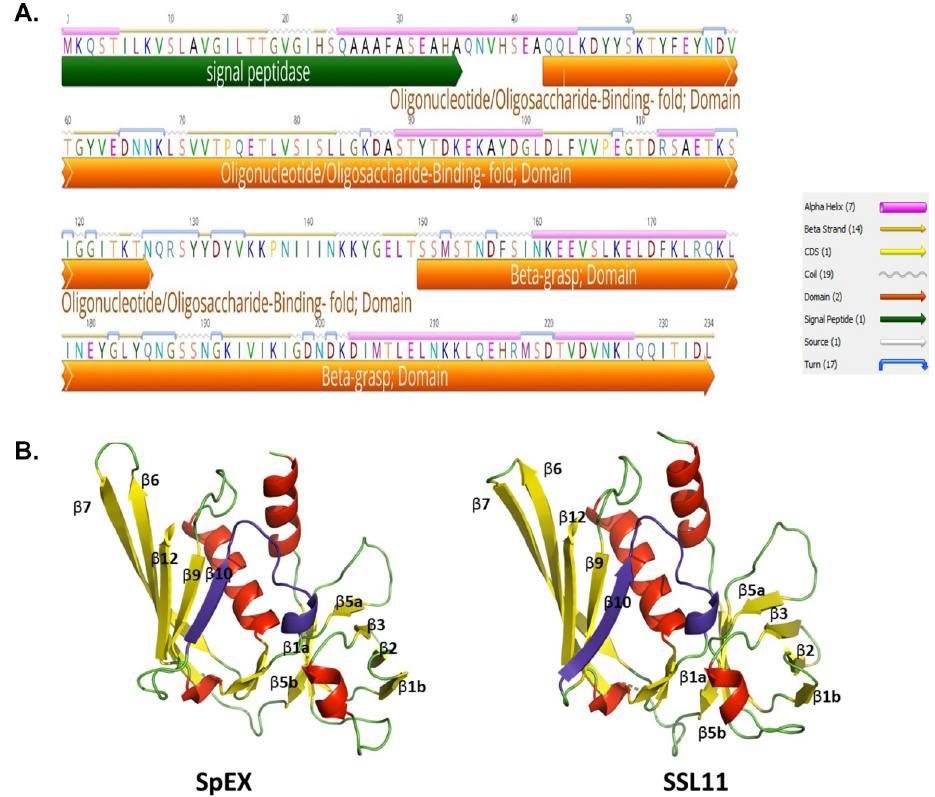
Fig 1. S . pseudintermedius SpEX structural characteristics. a. SpEX of S . pseudintermedius harbors an N-terminal signal peptide (green arrow) from position 1–35, OB domain (orange arrow) in residues 43–126 and C-terminal β grasp domain in residues 150–234 (orange arrow). b. The 3D model of S . pseudintermedius SpEX and S . aureus SSL11 shows the N and C terminal domains fold into a five-stranded beta-barrel structure consisting of β 1- β 5 and β 7, β 6, β 12, β 9 and β 10. A central helix is orientated diagonally in the center of the field from the top left to the bottom right leaving the N-terminal domain on the left and C-terminal domain on the right. A conserved sialated glycan binding domain forming V-shape depression is highlighted in purple in SpEX and SSL11 3D models.